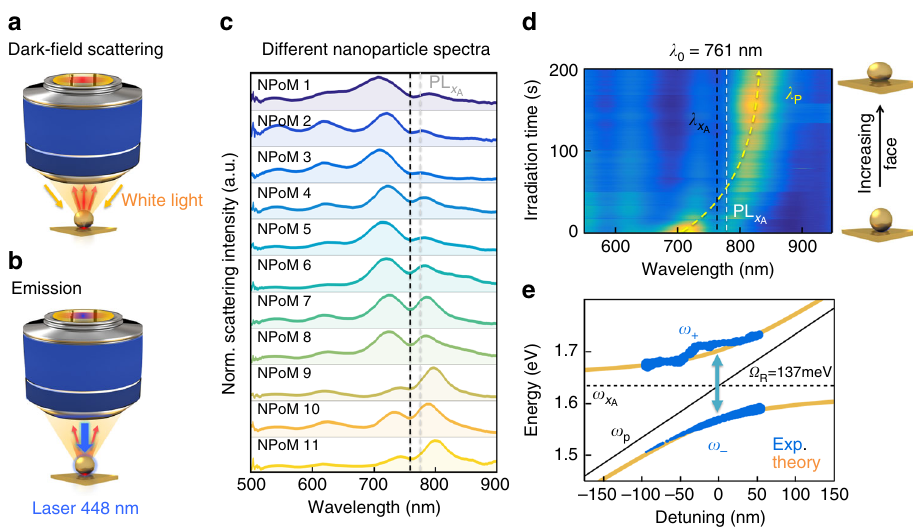
Fig. 3 Signature of strong coupling in individual NPoM constructs. a White-light dark- fi eld scattering, and b PL/irradiation setups. c Normalised dark- fi eld scattering spectra of individual NPoM constructs each with N L = 12 WSe 2 spacer, black dashed line at A exciton position. d , e Laser-induced tuning of NPoM plasmon resonance via growth of lower facet, mapping out anti-crossing around A exciton. e Hybrid plasmon – exciton branches (plexcitons, ω ± ) with Rabi-spitting Ω R = 137 meV. Blue dots correspond to extracted experimental values and orange to coupled oscillator